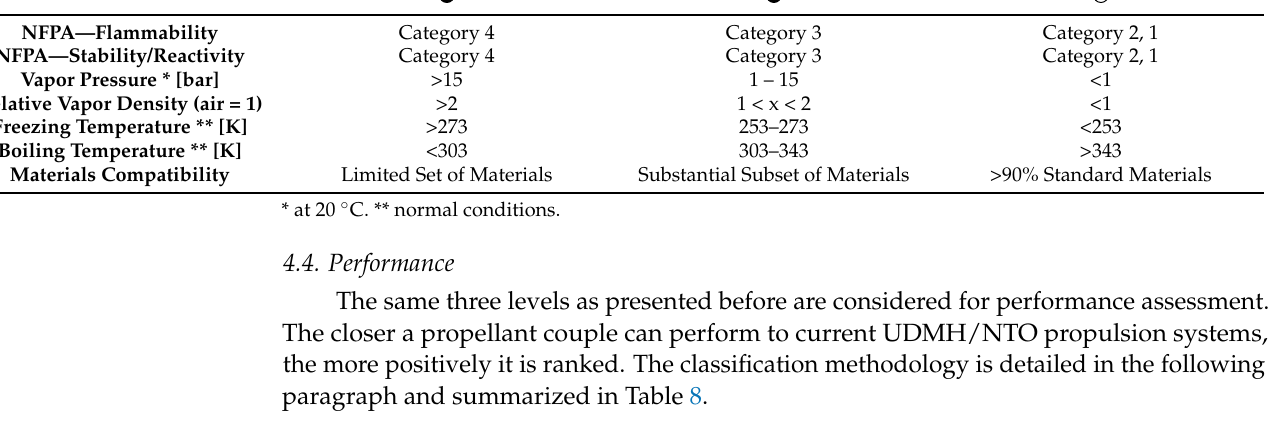
Table 8. Performance